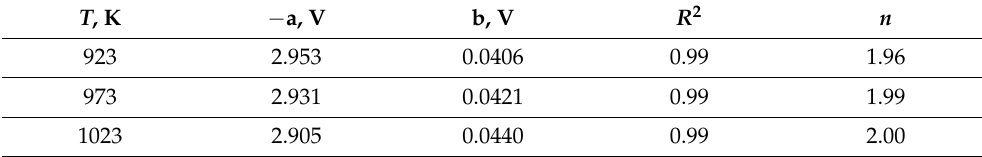
Table 3. Coefficients of isotherms and the degree of iron oxidation in the 0.66LiF–0.34BeF 2